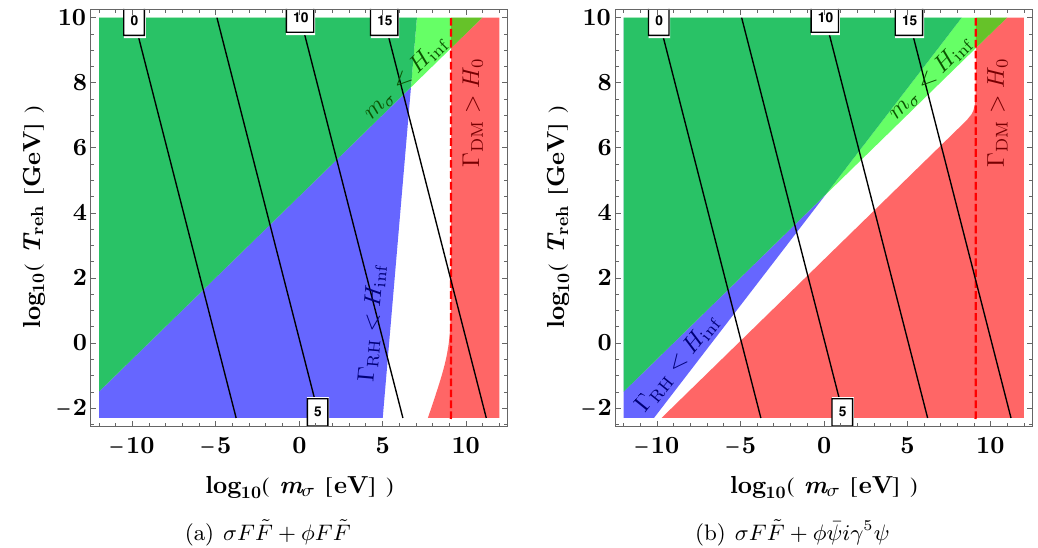
Figure 3 . Parameter space of axion-like fields in terms of its mass m σ and reheating tempera- ture T reh . Regions where the inflaxion makes up the dark matter is shown in white. The colored regions are excluded from the requirements of axion stabilization during inflation (green), dark mat- ter stability (red), and instantaneous reheating (blue). The lower end of the displayed T reh region is set by BBN. The axion decay constant is fixed to f = 10 17 GeV, and the inflaton-axion mixing constant to α = 1 / 2. In the left plot the inflaton is coupled to photons with G φγγ = 10 − 10 GeV − 1 , and in the right plot to fermions with g φff = 10 − 3 . Black solid contours show the inflaton mass ( m φ / eV). Red dashed lines show the edge of the dark matter stability exclusion in terms of log 10 region if the dark matter inflaxion were allowed to decay only through the σF ˜ F